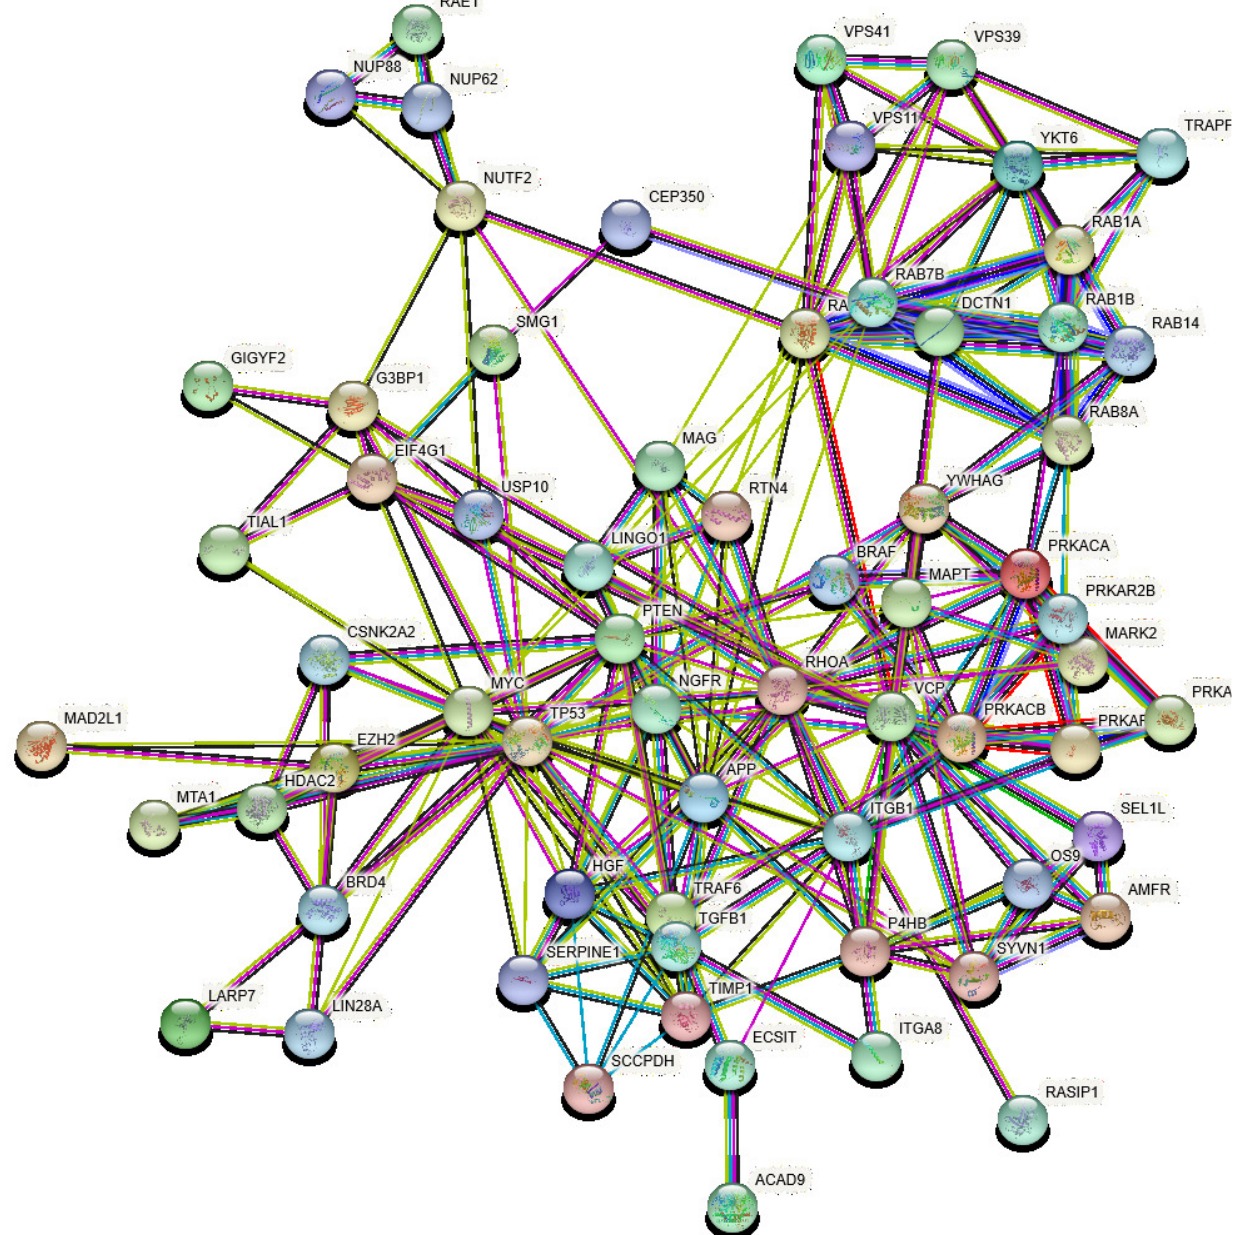
Figure 2. Protein-protein interaction network of all PD-VPs identified in this work and their perturbators. The network is built using STRING, and the edges are colored according to the way in which the corresponding PPI was determined: cyan, from curated databases; magenta, experimentally determined; green, gene neighborhood; red, gene fusions; blue, gene co-occurrence; lemon green, gene neighborhood; black, gene fusions; violet, gene